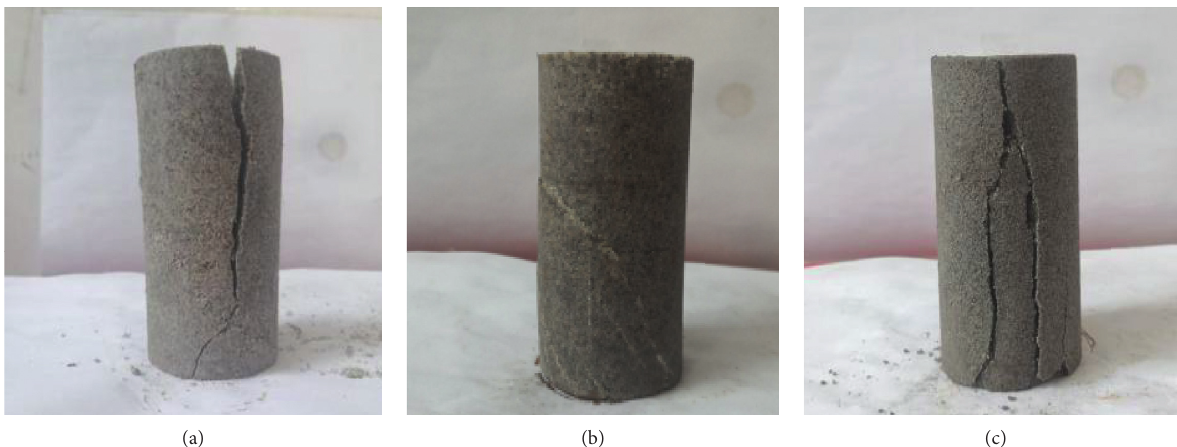
Figure 4: Fracture modes of samples: (a) tension failure, (b) shear failure, and (c) coupled failure.